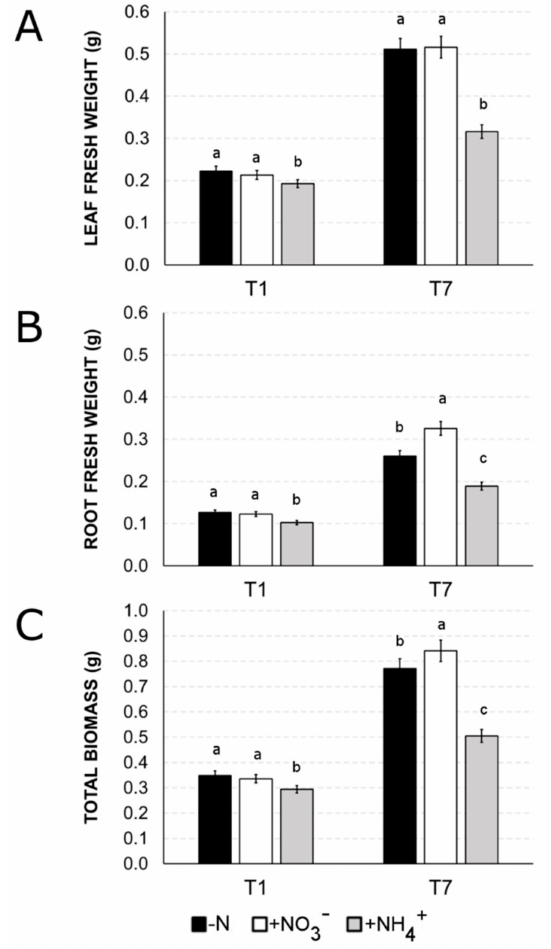
Figure 5. E ff ect of di ff erent N-source (NO 3 − or NH 4 + ) or N-deficiency (-N) on leaf biomass (fresh weight, panel A ) and root biomass (fresh weight, panel B ). The distribution of total biomass was reported in panel C . T1 shows the e ff ect after 24 h of treatment, T7 after 7 days. Similar letters at the top of the bars are not significantly di ff erent ( p < 0.05) by an ANOVA test. Each value is designed as the mean of three biological replicates ±